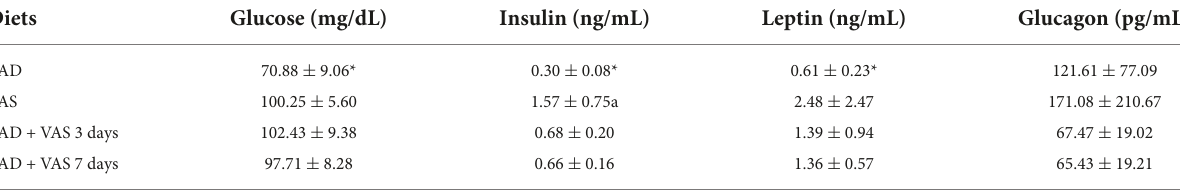
TABLE 3 Plasma glucose, insulin, leptin, and glucagon in Zucker lean (ZL) rats fed a vitamin A sufficient (VAS) or a vitamin A deficient (VAD) diet for 8 weeks, or those fed a VAD diet and followed by the VAS diet for 3 (VAD-VAS3d) or 7 (VAD-VAS7d). Diets Glucose